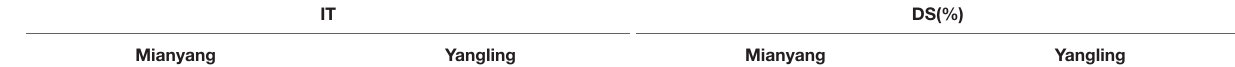
TABLE 1 | Correlation coefficients (r) of the mean infection type (IT) and disease severity (DS) of the Mingxian 169 × Pindong 34-derived recombinant inbred lines tested in different environments. IT DS(%) Mianyang Yangling Mianyang Yangling